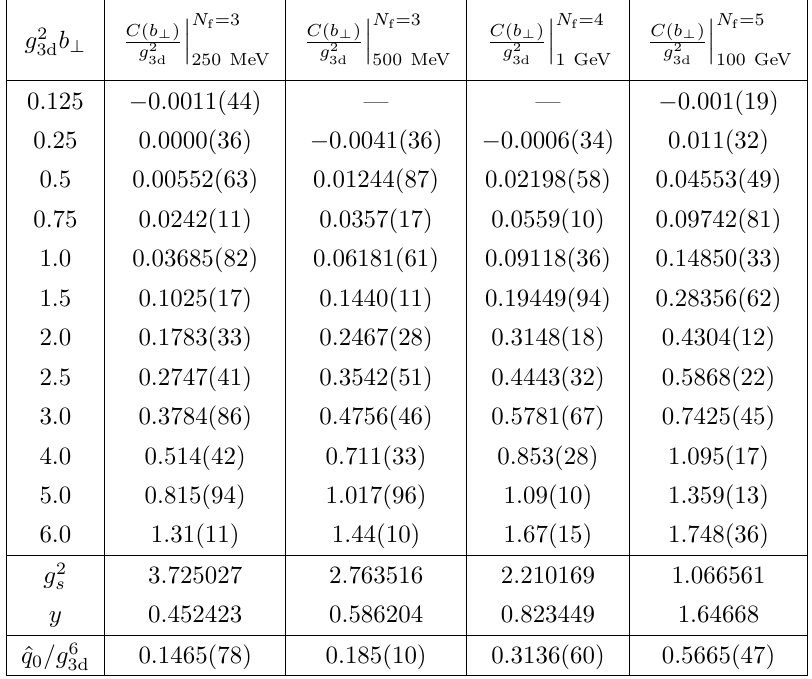
Table 1. Results for C QCD ( b ⊥ ) for four temperatures and a range of transverse separations b ⊥ . g 2 3d